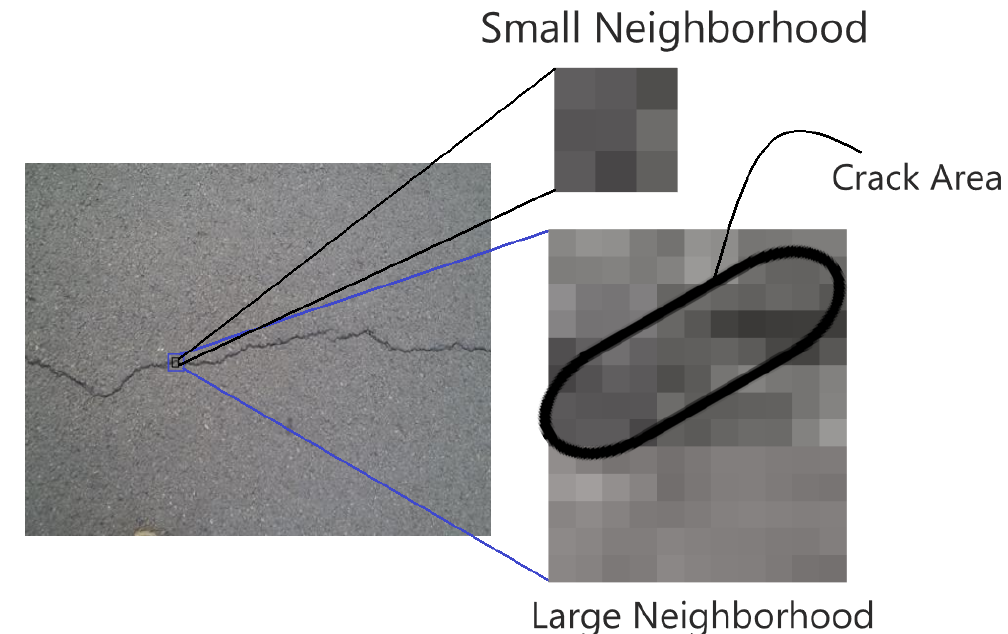
Figure 3. The comparison of two neighborhood of crack location from a small neighborhood and large neighborhood. Since crack pixels occur a very small amount of time, the small neighborhood only contains crack pixels. On the other hand, in the large neighborhood, the statistical relationship between crack and non-crack pixels can be captured more